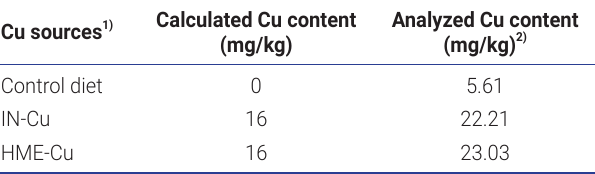
Table 2. Calculated and analyzed dietary Cu levels in broilers Cu sources